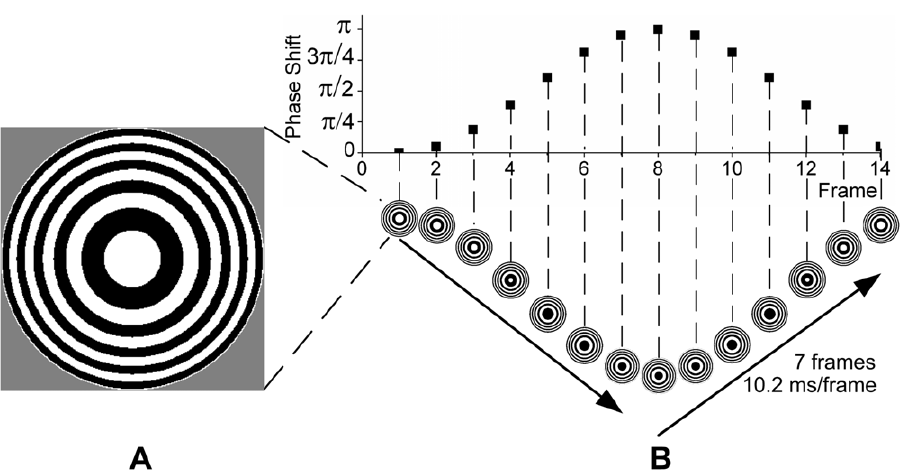
Figure 1. Motion reversal stimulation. (A) A Newton’s ring based stimulator. (B) The motion reversal procedure of the rings. It was illustrated with a 14 Hz motion reversal frequency and each reversal contained 7 frames. The phase of the Newton’s ring was modulated by a sinusoid of 7 Hz in [0, p ] to produce motion reversals.